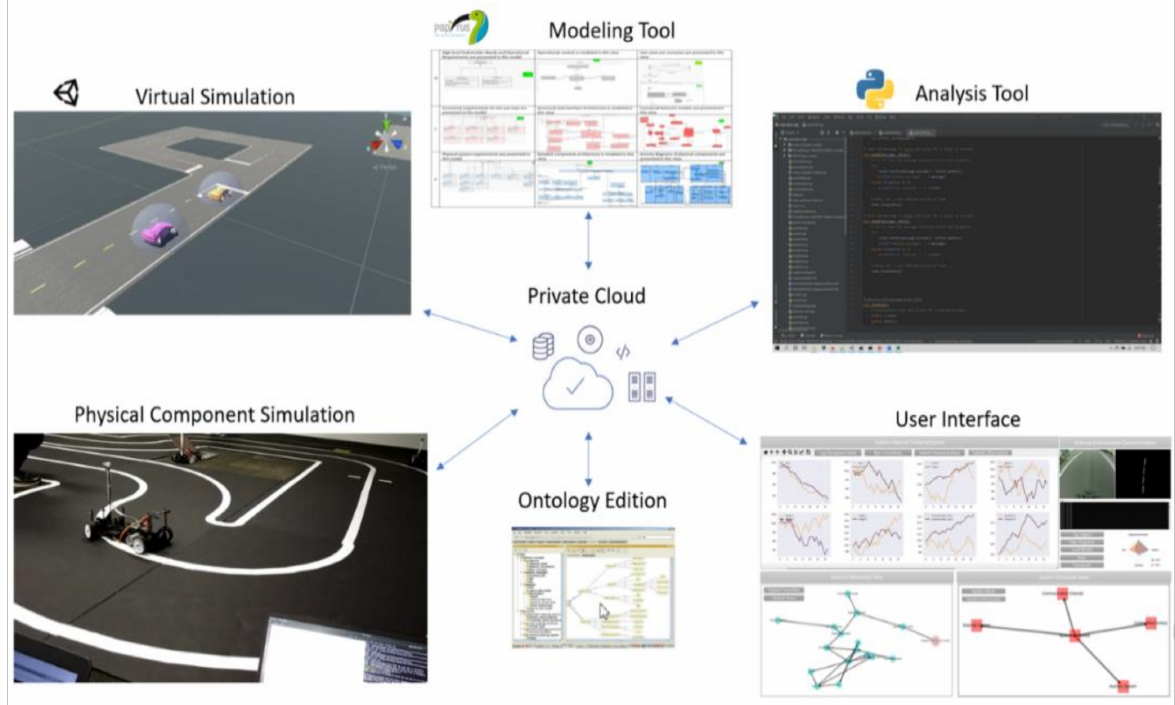
Figure 11. Testbed implementation